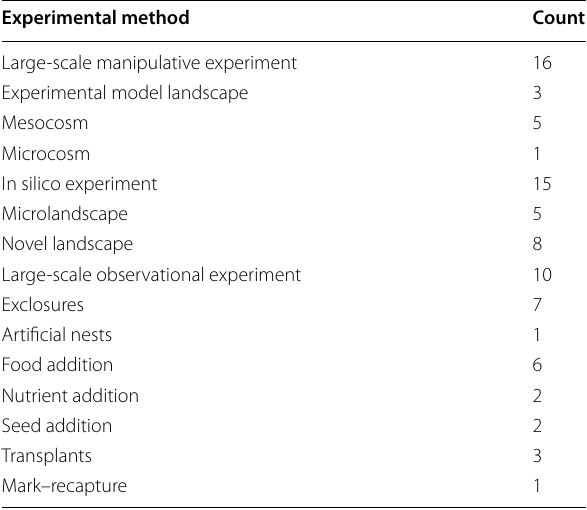
Table 2 Summary of experimental methods found in the 85 papers reviewed that examined spatial dimensions of ecological processes